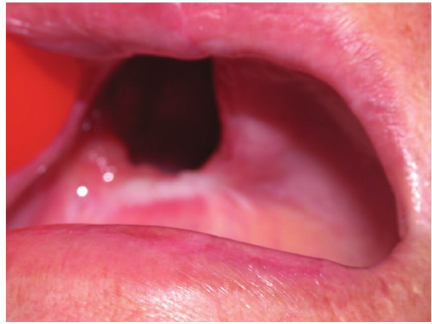
Figure 6: Clinical aspect after treatment.